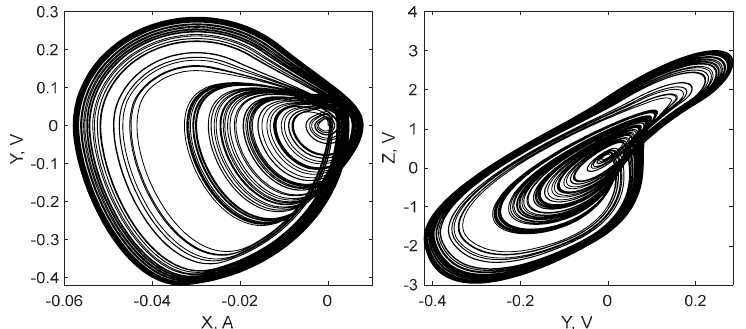
Sensors 2019 , 19 , x FOR PEER REVIEW Figure 12. Attractor of the designed circuit in the chaotic mode of oscillations.